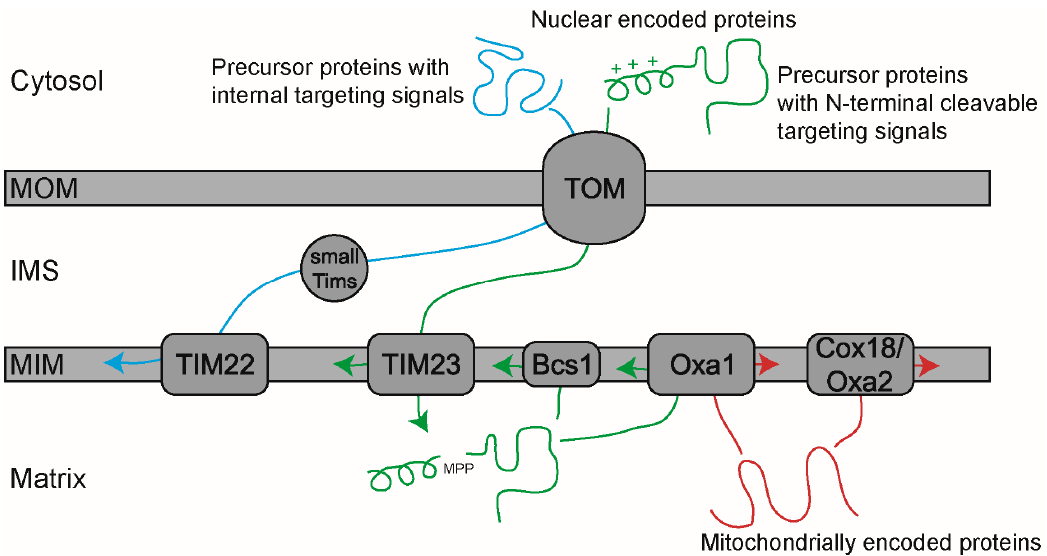
Figure 1. Mitochondrial protein transport and inner membrane insertion pathways. The MIM proteins can follow several routes for membrane insertion. There are the two translocase complexes in the inner membrane, TIM22 and TIM23, which laterally insert nuclear-encoded proteins into the MIM. Proteins with internal targeting signals are inserted into MIM by TIM22, while those with cleavable N-terminal targeting signals are inserted by TIM23. The conservatively sorted proteins are first targeted to the matrix by TIM23 and then inserted to the MIM in a manner reminiscent of bacterial inner membrane protein insertion. These conservatively sorted and mitochondrial-encoded proteins require Oxa1 or Cox18 (Oxa2) for membrane insertion. The newest member for conservative sorting is the Bcs1 protein for membrane insertion of the Rieske Fe/S protein. MOM = mitochondrial outer membrane, IMS = intermembrane space, MIM = mitochondrial inner membrane, MPP = mitochondrial processing peptidase, Oxa = oxidase assembly factor, TIM = translocase of the inner